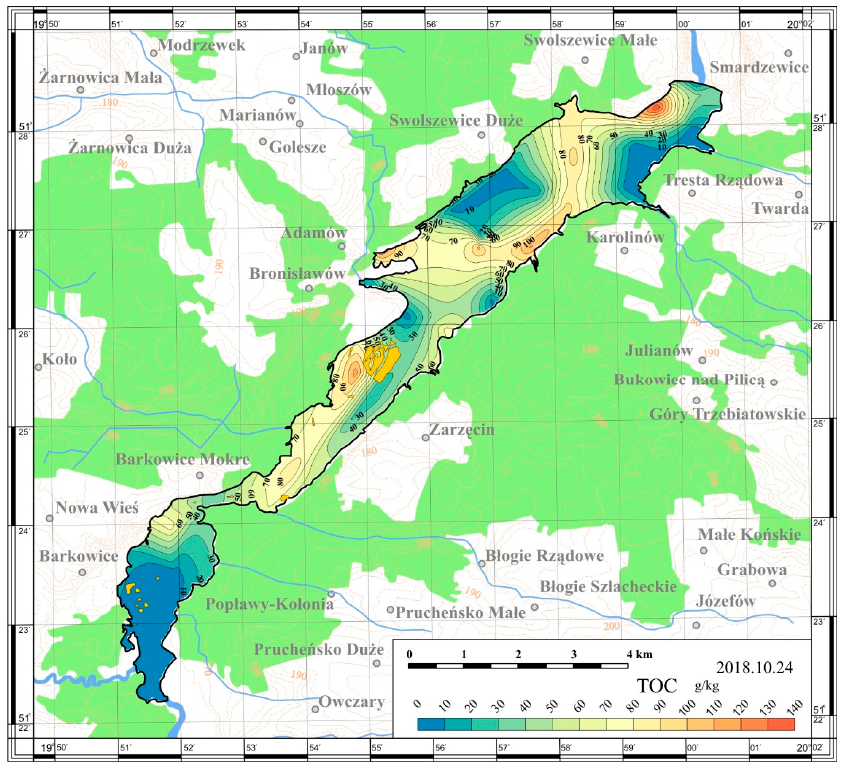
Figure 7. Spatial distribution of the total organic carbon content in the bottom sediments of the Figure 7. SpatialdistributionofthetotalorganiccarboncontentinthebottomsedimentsoftheSulej ó Sulejów Reservoir.